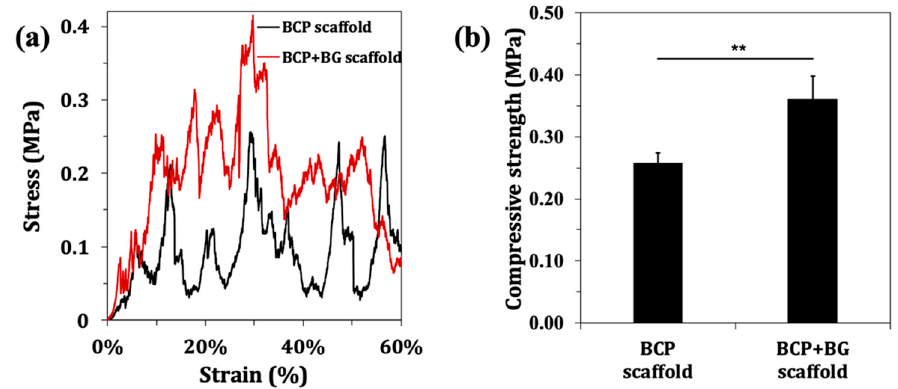
Figure 4. Compressive strength of the uncoated and BG-coated BCP scaffolds: (a) representative stress-strain curve; (b) maximum compressive strength during the deformation period. The results are represented as the mean ± SD (**P < 0.01).